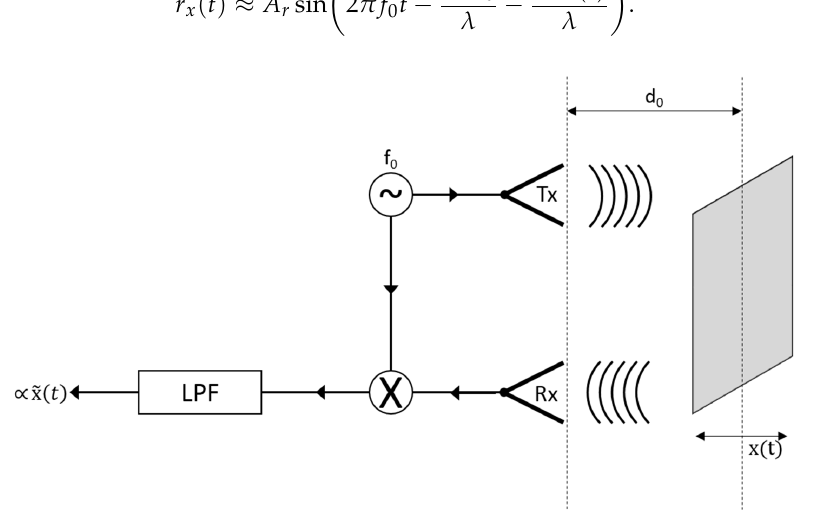
Figure 2. CW Doppler radar for vibration detection.